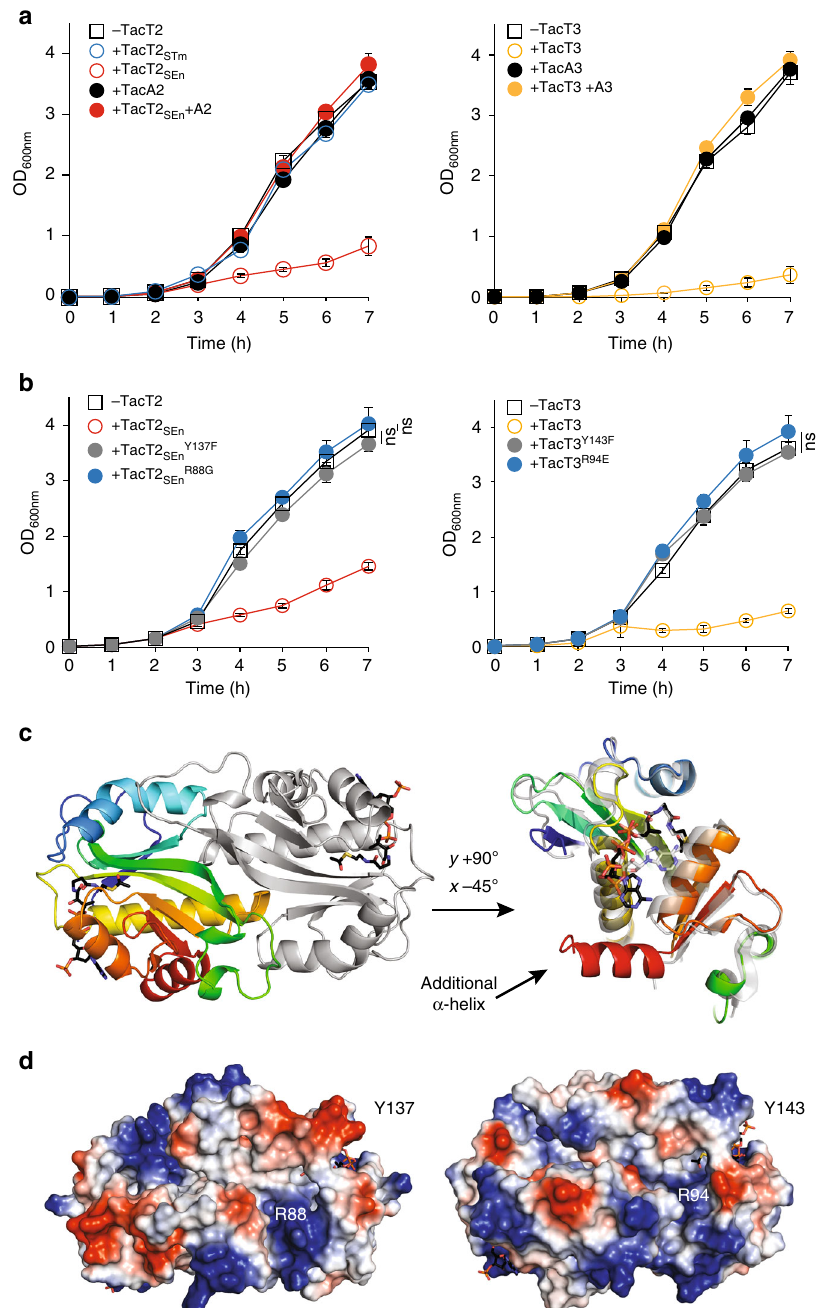
Fig. 2 TacT2 SEn and TacT3 are functional acetyltransferase toxins. a Left panel: Growth curves of S . Typhimurium 12023 Δ tacTA2 carrying pBAD33 ( − TacT2), pBAD33:: tacT2 STm ( + TacT2 STm ), pBAD33:: tacT2 SEn ( + TacT2 SEn ), pCA24N:: TacA2 ( + TacA2) or pBAD33:: tacT2 SEn and pCA24N:: tacA2 ( + TacT2 SEn + TacA2). Right panel: Growth curves of S . Typhimurium 12023 Δ tacTA3 carrying pBAD33 ( − TacT3), pBAD33:: tacT3 ( + TacT3), pCA24N:: TacA3 ( + TacA3) or pBAD33:: tacT3 and pCA24N:: tacA3 ( + TacT3 + TacA3). All cultures were supplemented with arabinose and IPTG in fresh rich medium during the lag phase and growth was monitored by optical density. b Left panel: Growth curves of S . Typhimurium 12023 Δ tacTA2 expressing from pBAD33, the wild-type S . Enteritidis toxin ( + TacT2 SEn ) or point mutant toxins ( + TacT2 Y137F SEn ) or ( + TacT2 R88G SEn ), or carrying the empty vector ( − TacT2). Right panel: Growth curves of S . Typhimurium 12023 Δ tacTA3 expressing from pBAD33, the wild-type toxin ( + TacT3), or point mutant toxins ( + TacT3 Y143F ) or ( + TacT3 R94E ), or carrying the empty vector ( − TacT3). All cultures were supplemented with arabinose in fresh rich medium during the lag phase. c Left panel: Cartoon representation of the dimeric structure of TacT3 Y143F . Chain A is coloured from blue at the N terminus to red at the C terminus, and Chain B is coloured light grey. Right panel: Cartoon superimposition of TacT3 Y143F (coloured) and TacT Y140F (grey). TacT3- and TacT-bound Ac-CoA molecules are shown as black and grey sticks, respectively. (PDB: 6G96). d Electrostatic potential of the surface of the modelled TacT2 SEn (left panel) or TacT3 (right panel) dimer showing positive potential in blue and negative in red. Residues mentioned in the text are labelled. a , b Data represent the mean ± SEM ( n ≥ 3) and were analysed using a Student ’ s t test (ns, non-signi fi